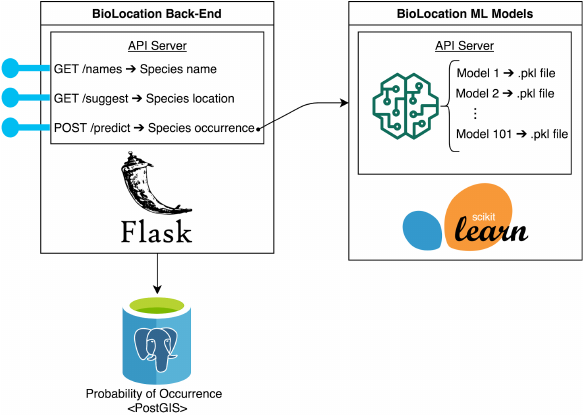
Figure 8. The architecture of BioLocation API